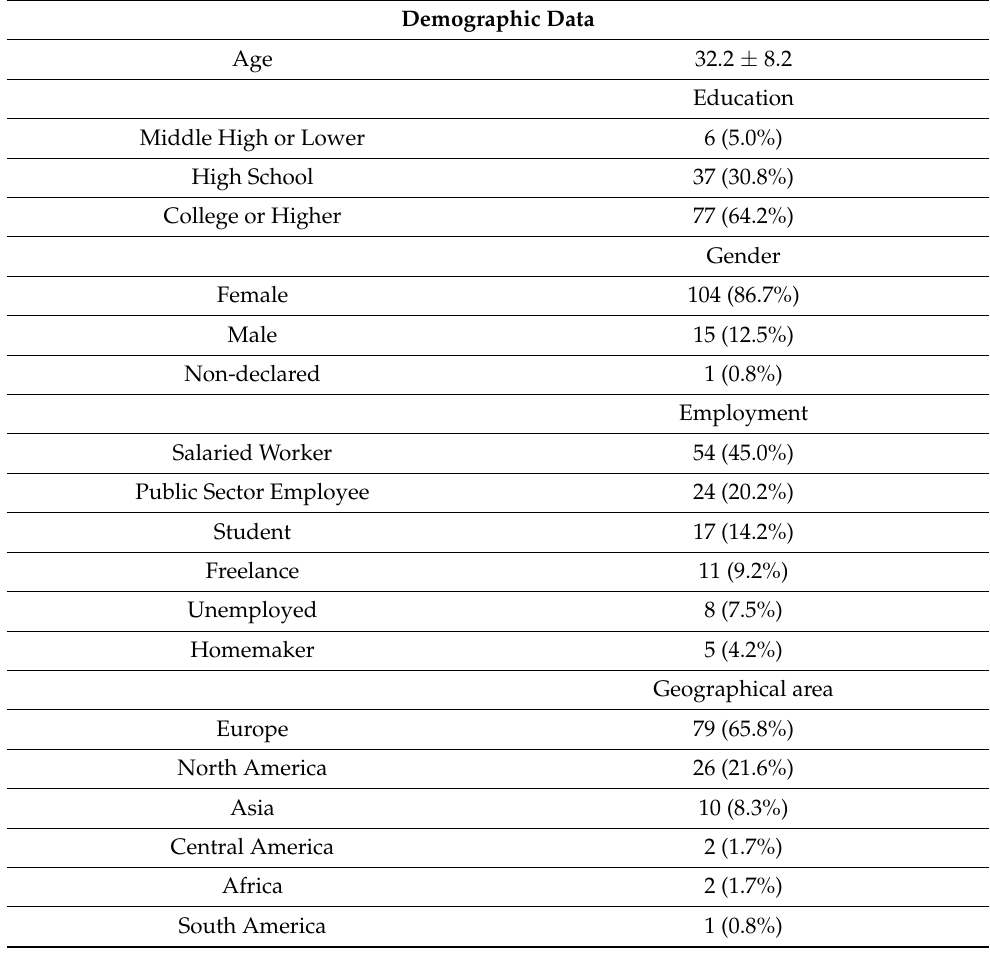
Table 1. Demographic data expressed as absolute number (percentage).